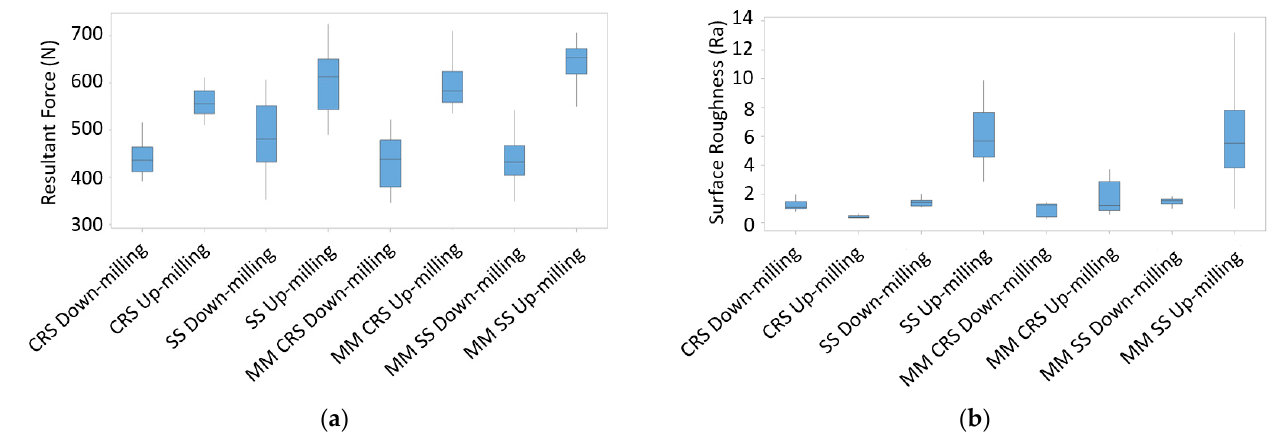
Figure 10. ( a ) Resultant force and ( b ) surface roughness results for up ‐ and down ‐ milling.